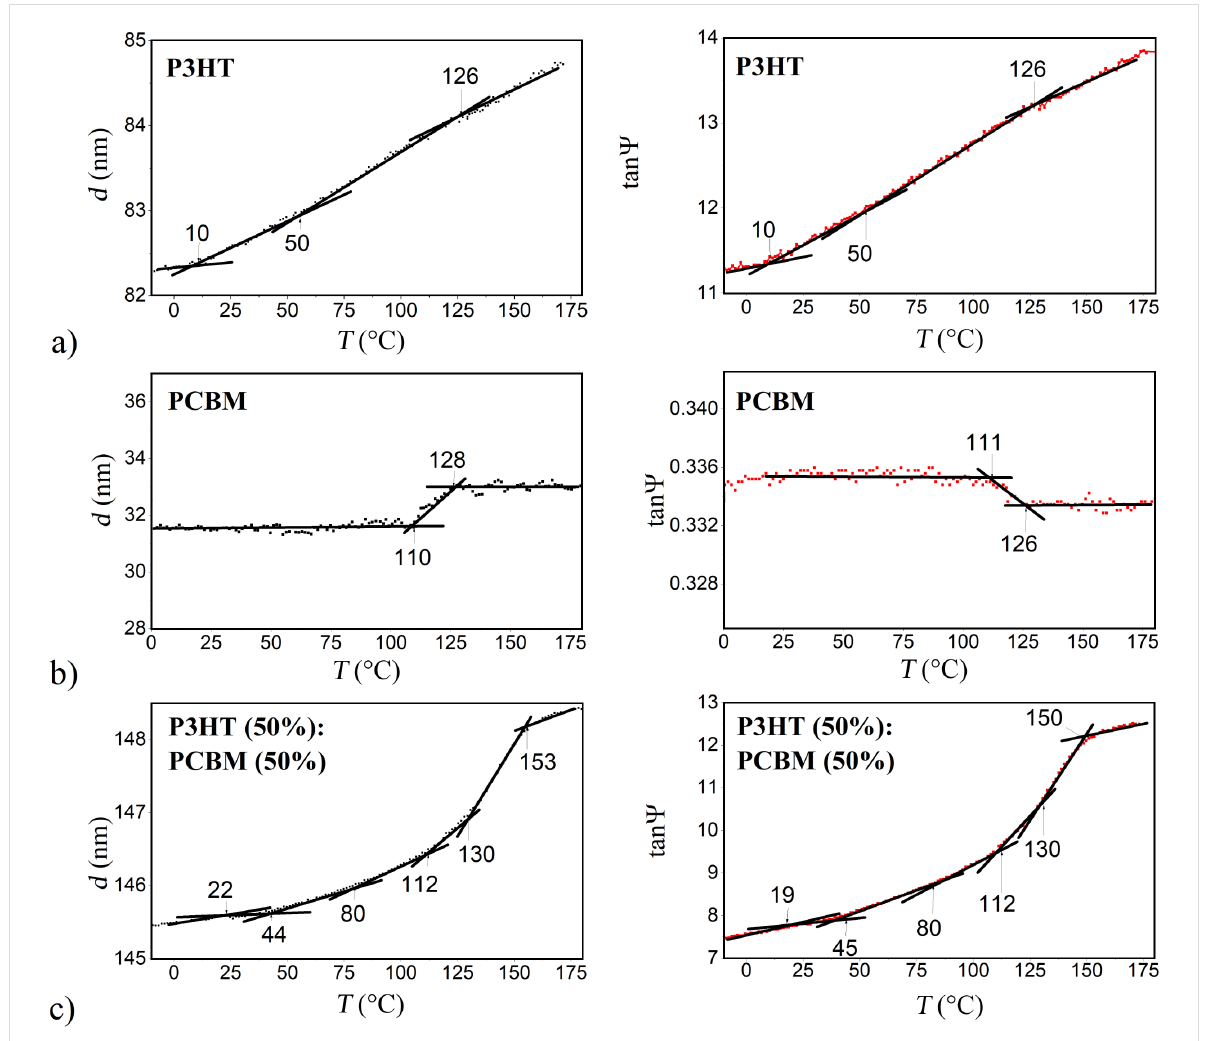
Figure 3: Thickness d and tan Ψ as functions of the temperature for (a) P3HT, (b) PCBM and (c) P3HT:PCBM (1:1) thin films.